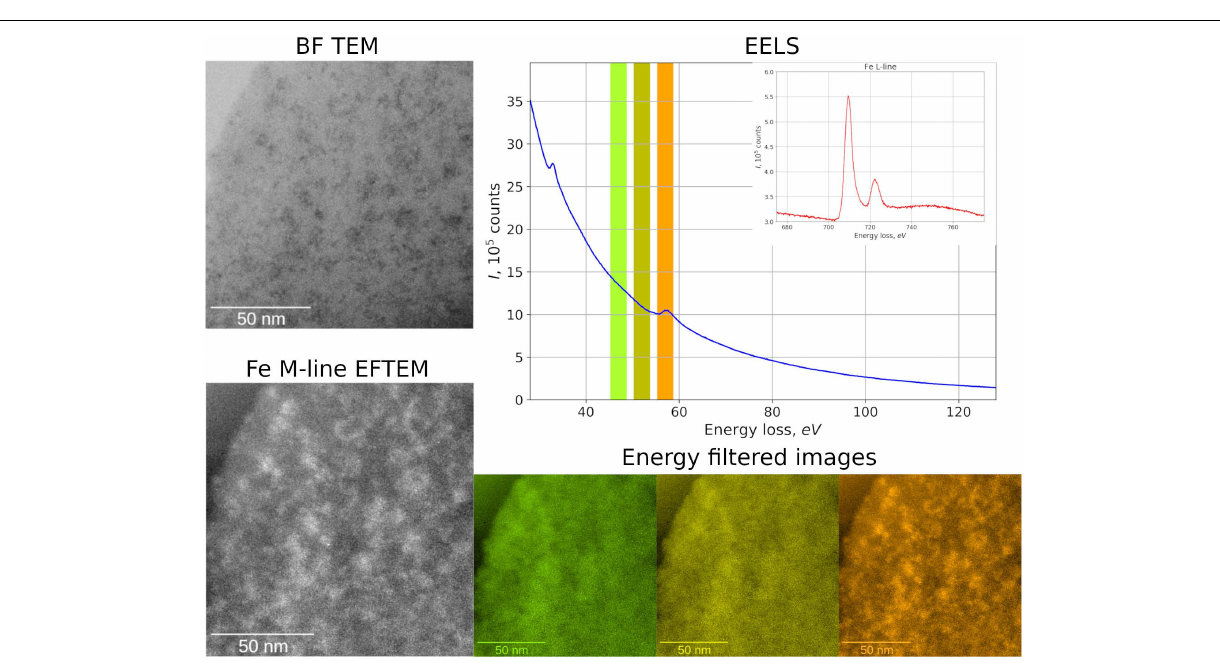
FIGURE 2 | TEM, Fe M-line EFTEM, EELS spectra and the scheme of EFTEM measurements for the product